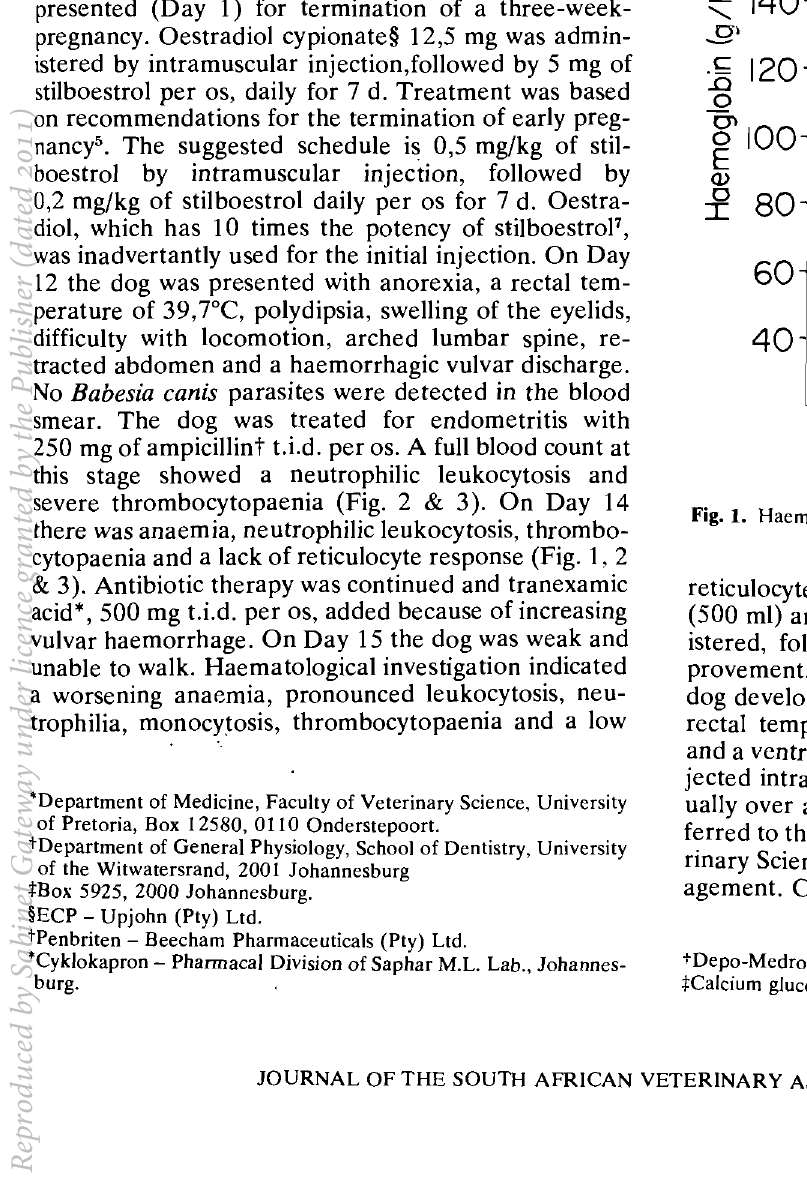
Fig. 1. Haemoglobin c'o}lcentration